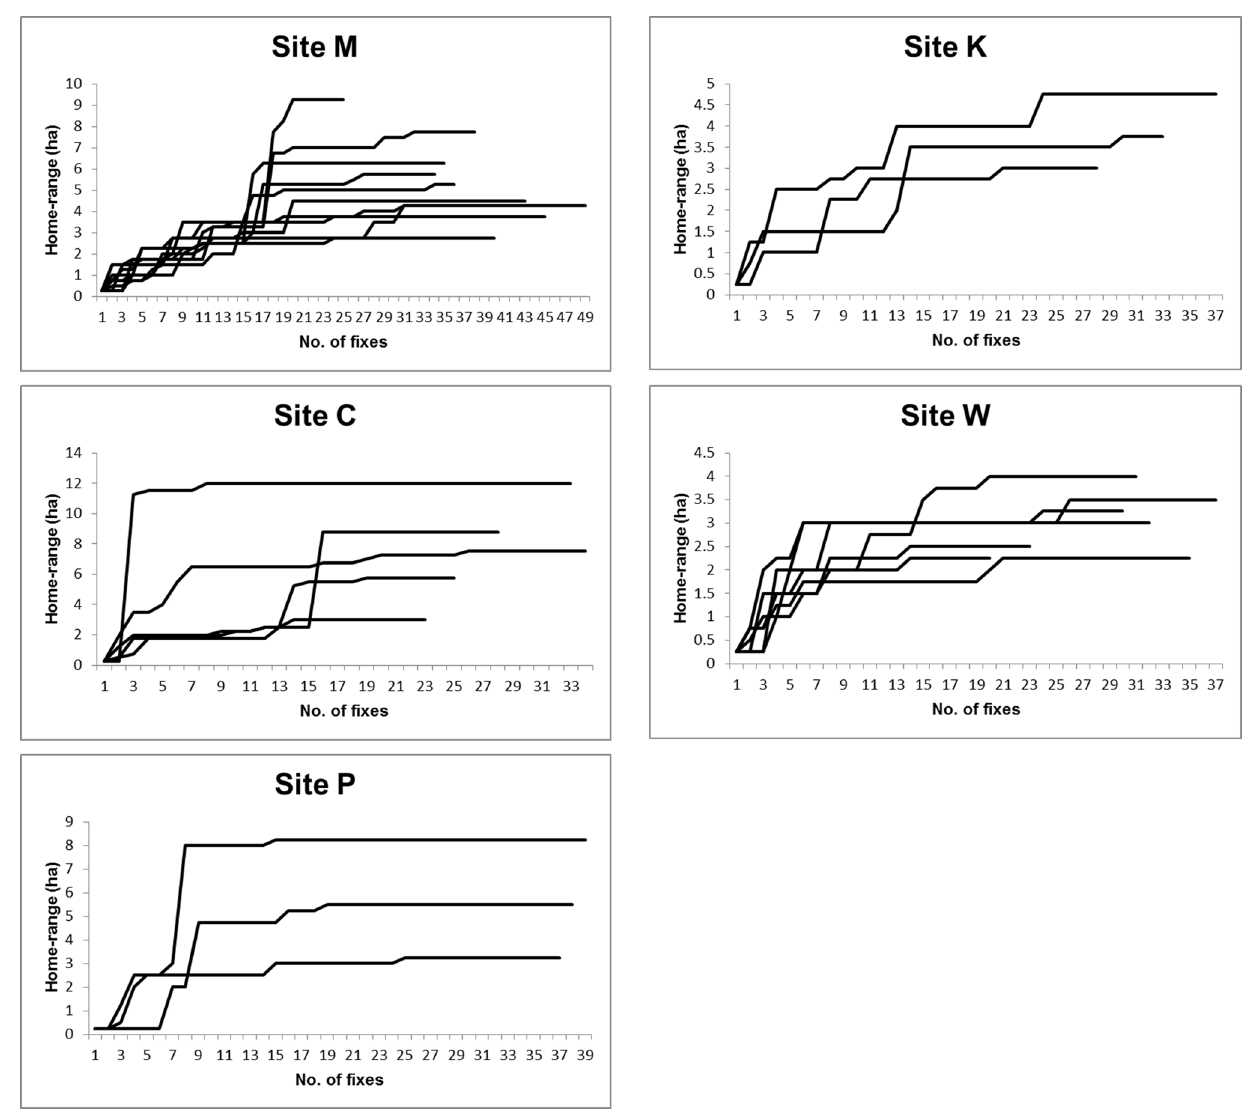
Figure 4. Home range estimates plotted against the number of fixes in sequential tracking order. The fixes are for all animals (with . 20 fixes) at each of the five study sites.